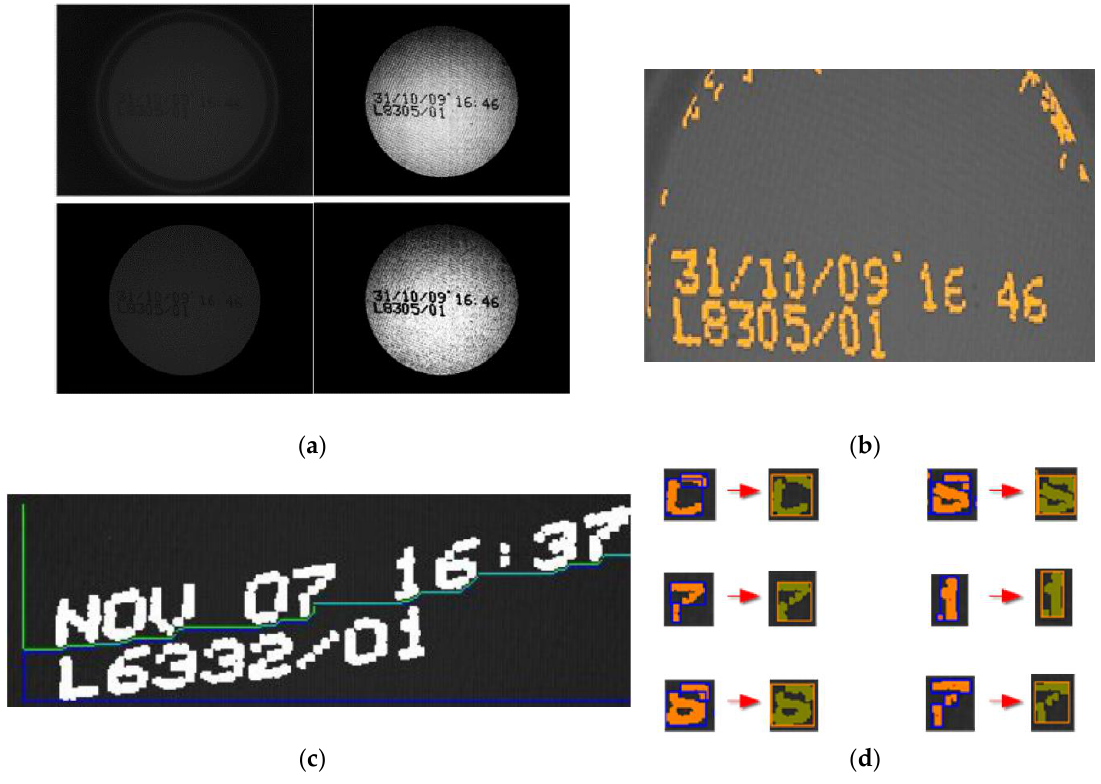
Figure 4. ( a ) Enhancement and equalisation of the area of interest. ( b ) Separation of ink and background. ( c ) Arranging the ink fragments into lines of text. ( d ) Grouping of ink fragments into characters.